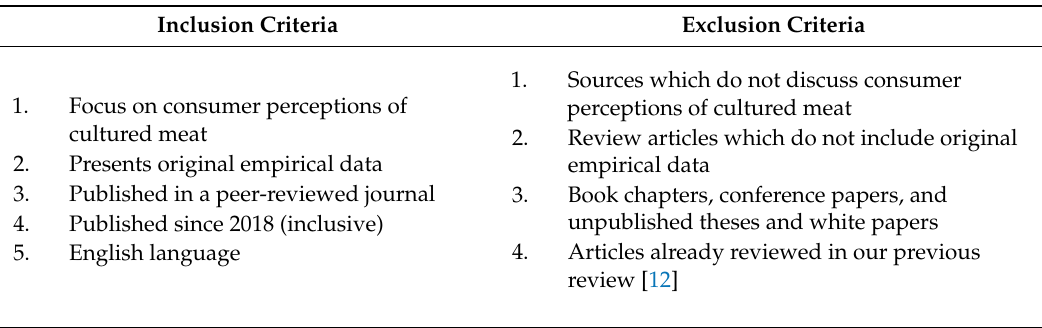
Table 1. Inclusion and exclusion criteria.